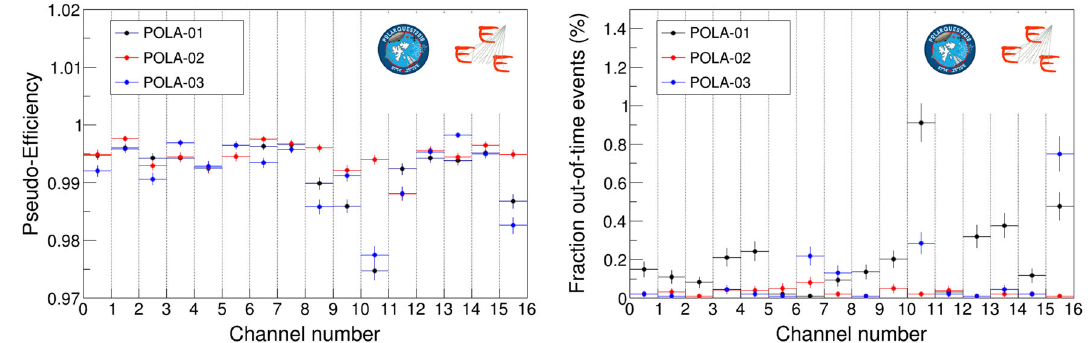
Fig. 7 Left: Pseudo-Efficiency, channel-by-channel, for POLA-01, POLA-02 and POLA-03. Right: Fraction of events out of time, channel by channel, for the three POLA detectors. All plots refer to data taken on July 27, 2018